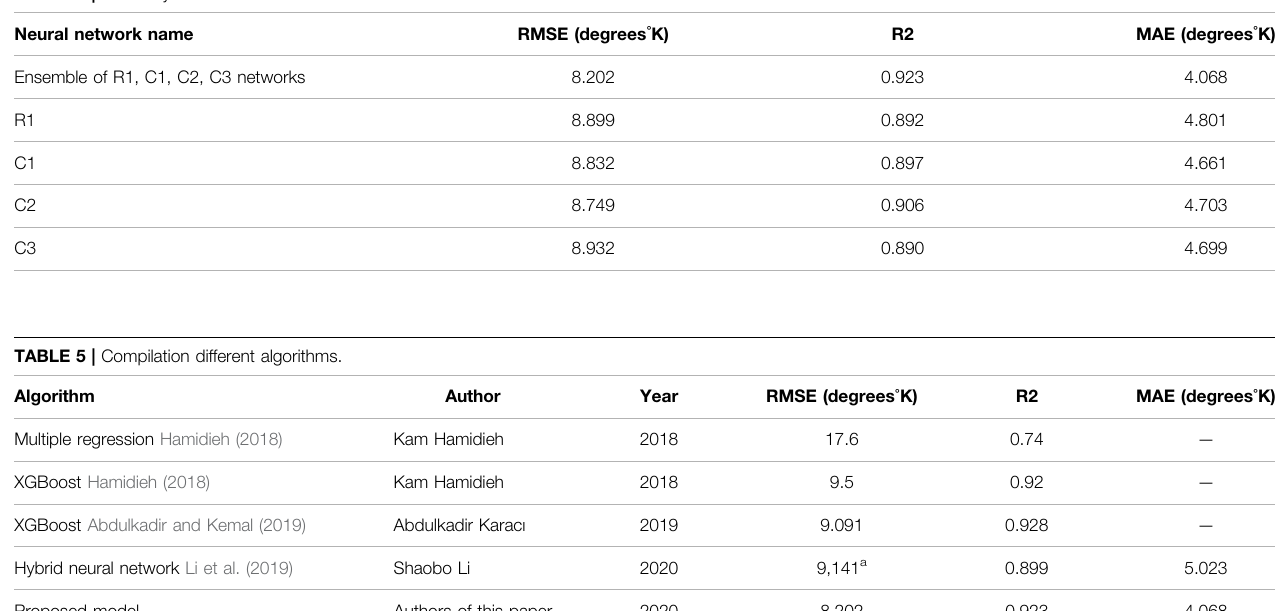
The fi nal ensemble of neural networks has 1,330,247 trainable parameters.